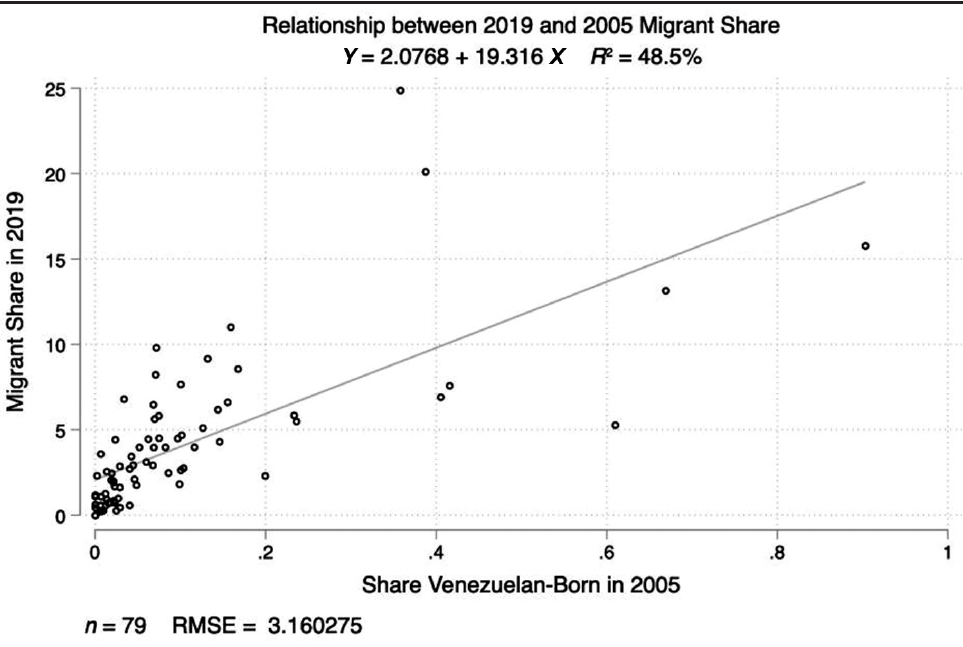
Figure A3 Relationship between 2019 and 2005 migrant shares.